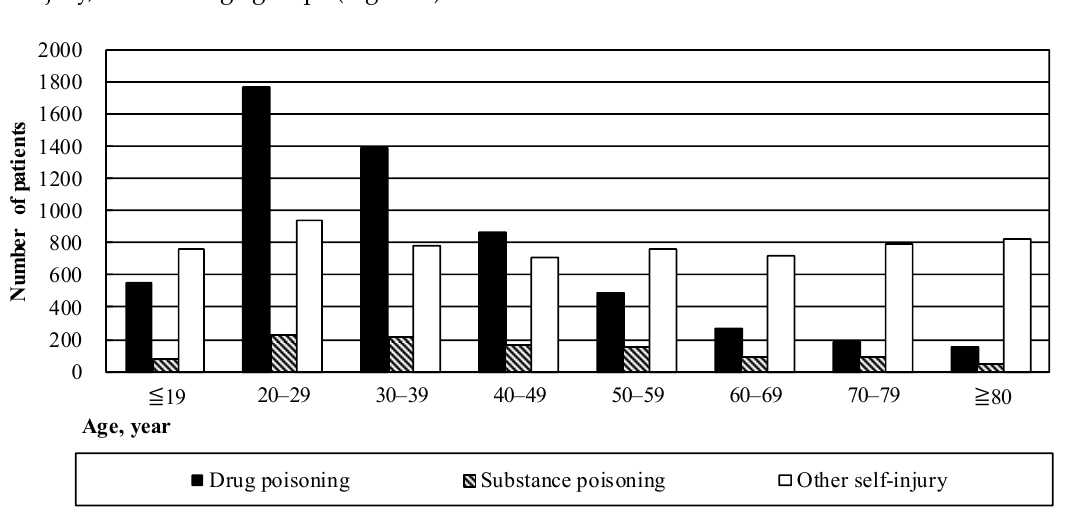
Figure 1. Observed numbers of patients according to age group and type of deliberate self-harm, for every third September between 1996 and 2014.